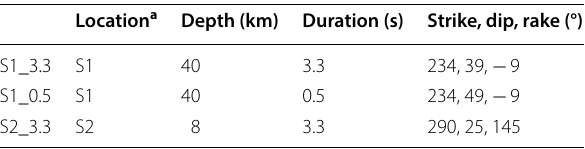
Table 1 Point source models